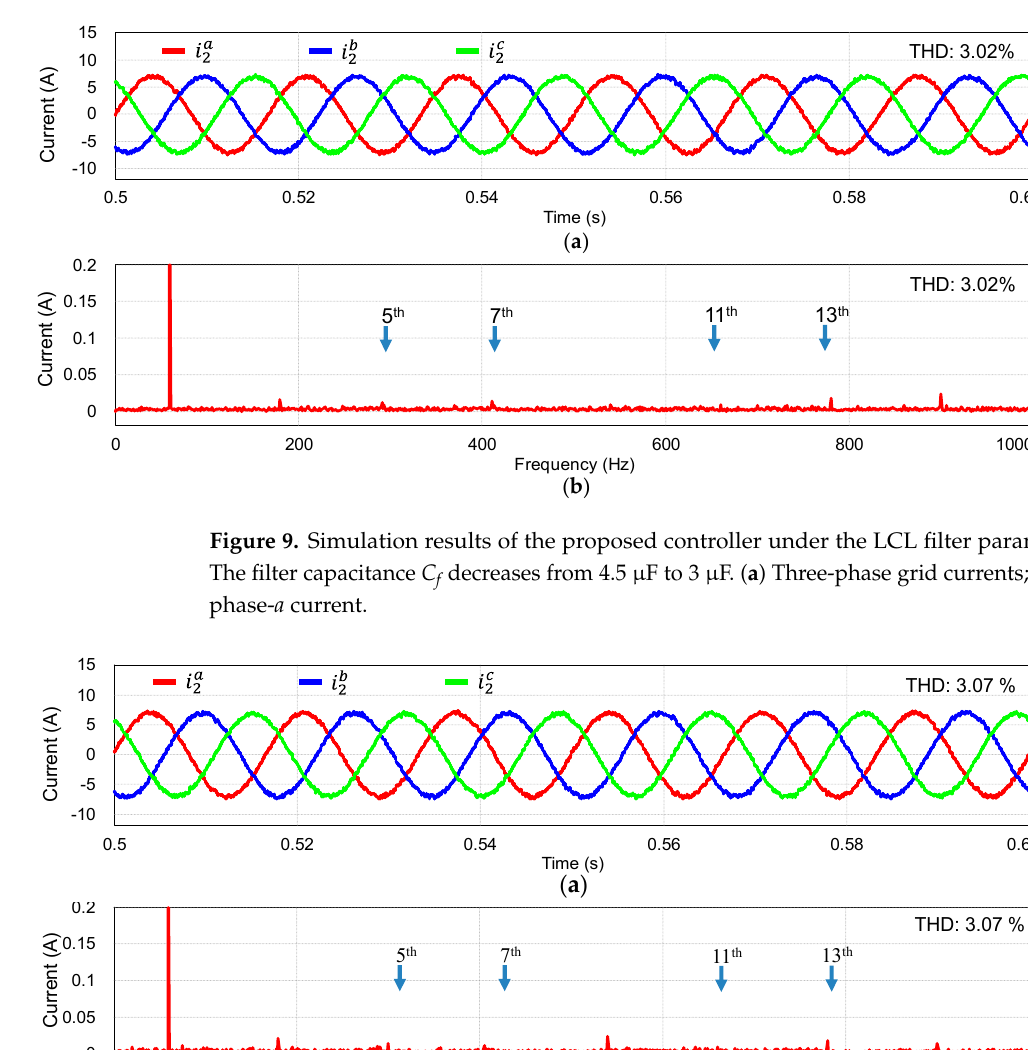
Figure 9. Simulation results of the proposed controller under the LCL filter parameter variations: The filter capacitance C f decreases from 4.5 μ F to 3 μ F . ( a ) Three-phase grid currents; ( b ) FFT result of phase- a current.